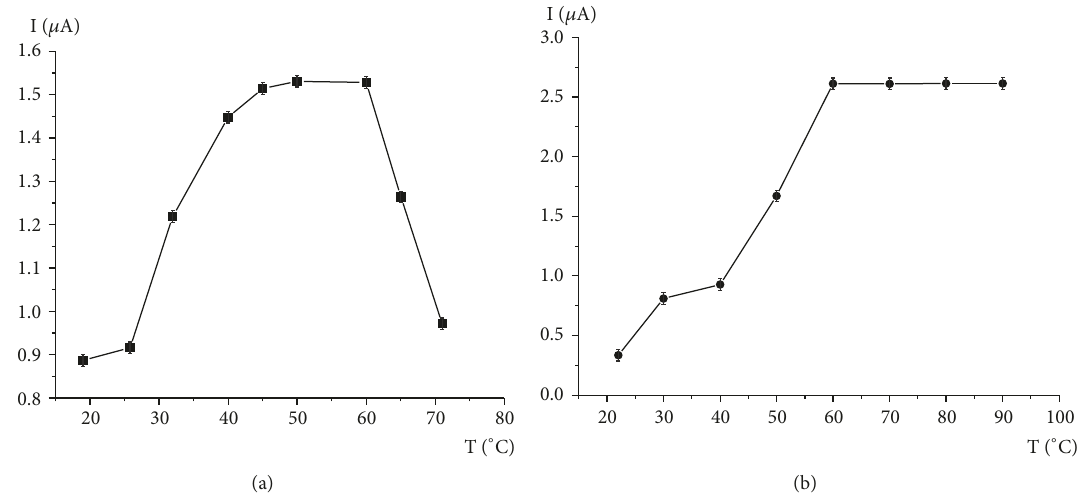
Figure 5: Effect of temperature on the oxidation product yield (for peak P1) of BC (a) and PC (b) C PMS = 10 −3 mol ⋅ L −1 , C BC = C PC =5 ⋅ 10 −5